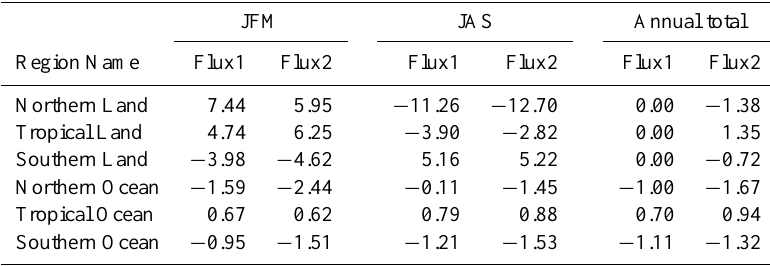
Table 1. Regionally aggregated non-fossil fuel carbon budgets (unit is PgCyr − 1 ) of Flux1 and Flux2. Definition of the regional boundary is the same as that of TransCom3 (Gurney et al., 2004).